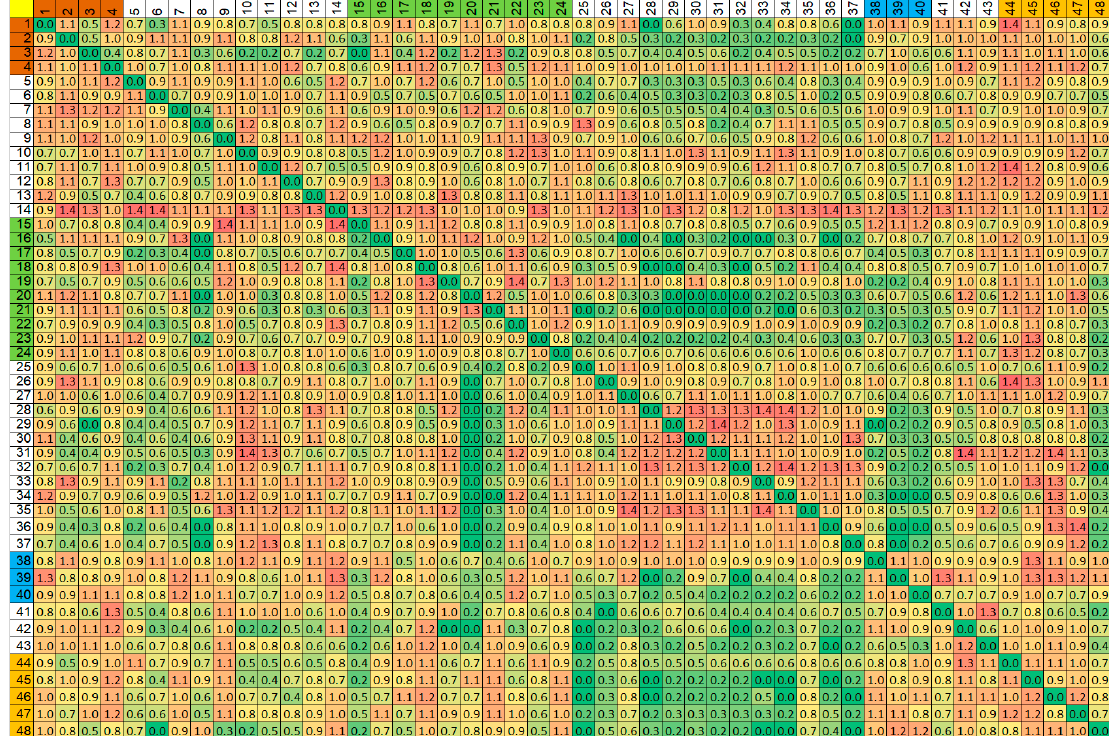
Figure 4. Values of standard deviations (numbers of rows and columns and the coloured areas relate to variables corre- sponding to the description of the variables—see Table 1).